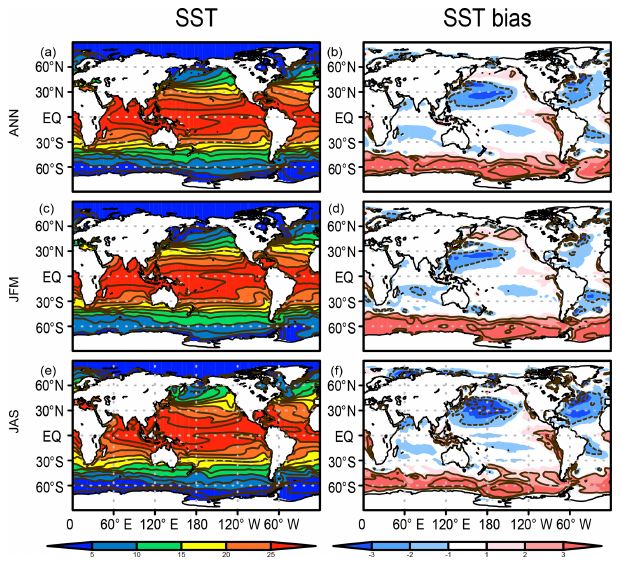
Figure 5. SST ( ◦ C) in the HIST simulation presented as a 1955– 2012 climatology and the bias in comparison with WOA2013 (Lo- carnini et al., 2013) for (a, b) annual, (c, d) JFM, and (e, f) JAS means.